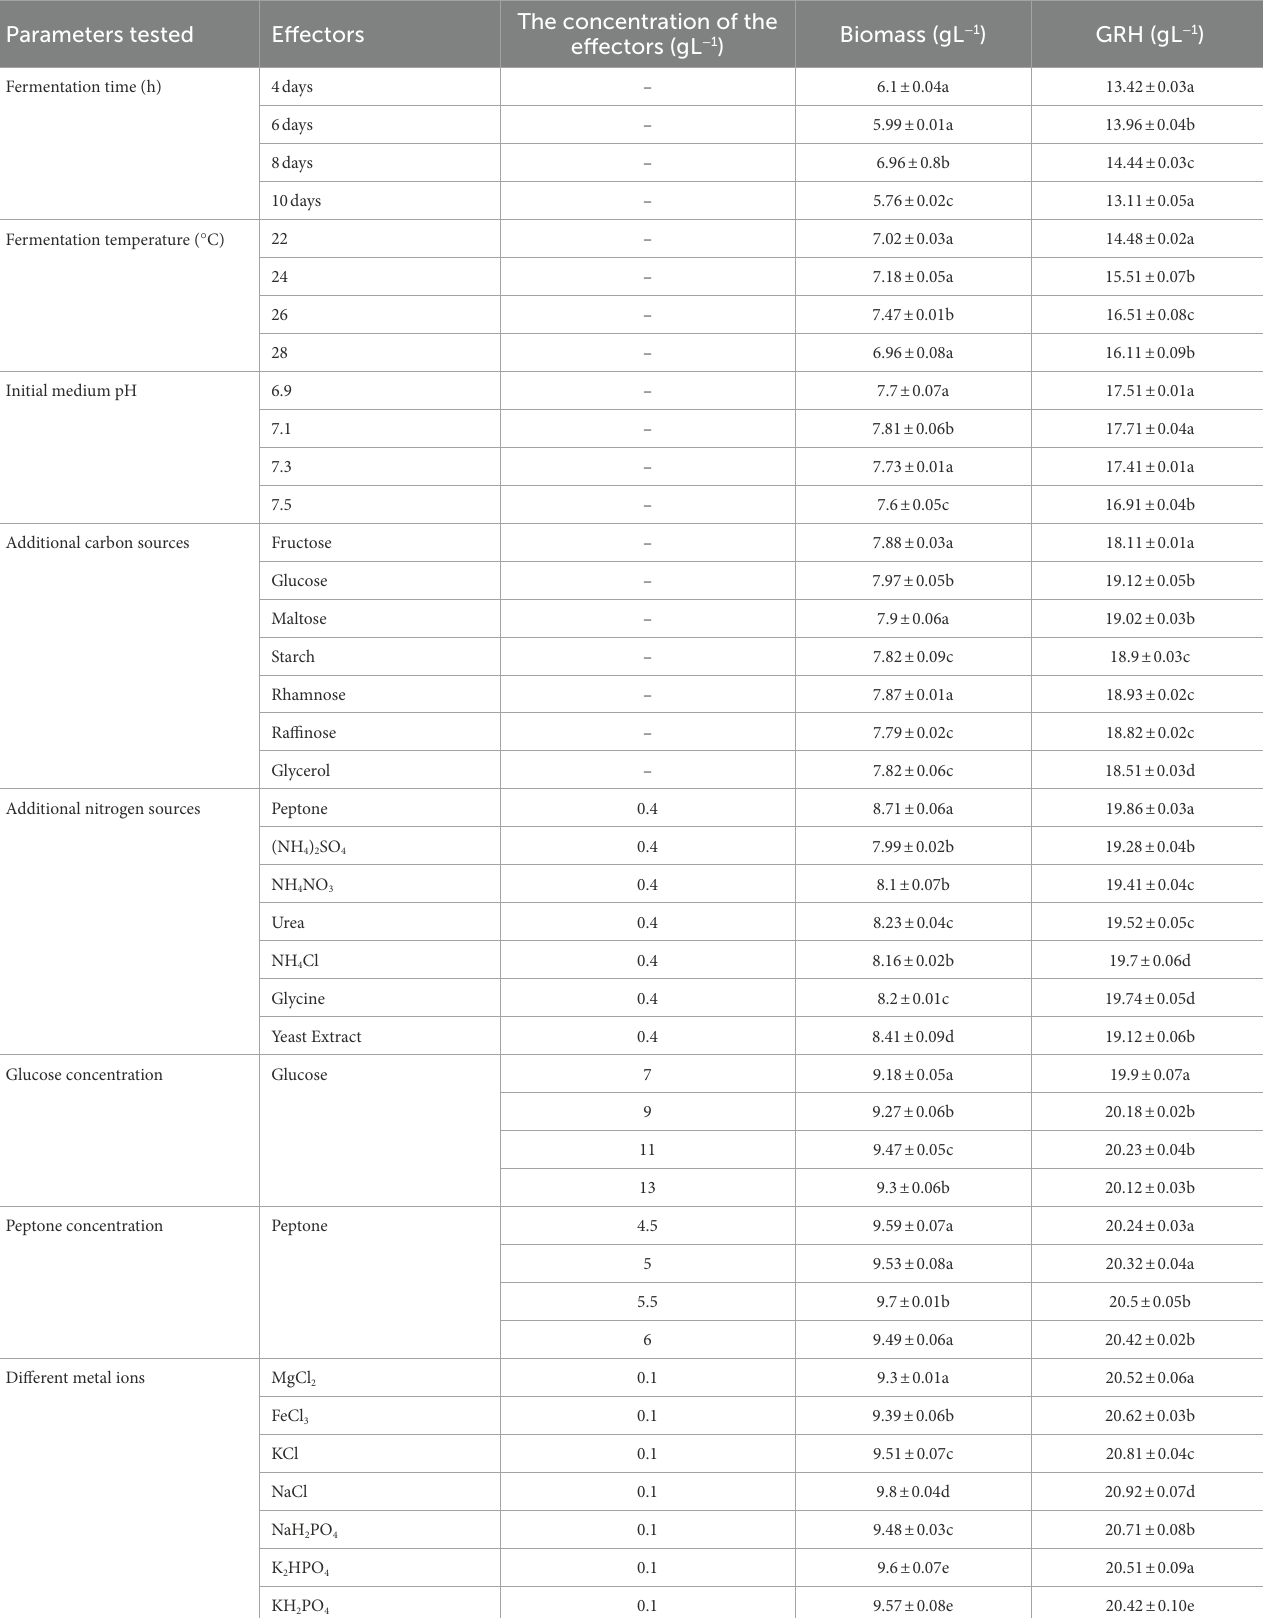
TABLE 1 Effect of different fermentation influencing physical conditions and chemical supplements, on biomass and Galactose Rich Heteropolysaccharide production by endophytic fungi Mucor sp. HELF2 in submerged fermentation conditions. Parameters